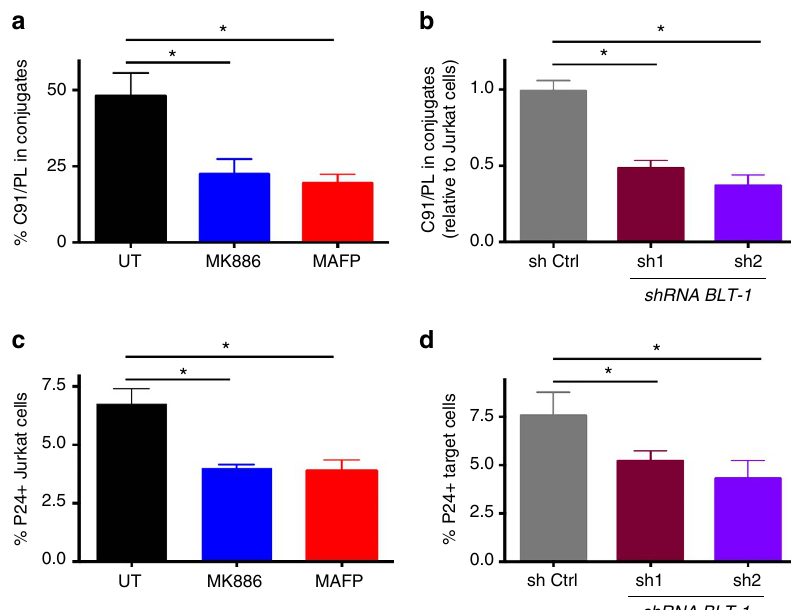
Figure 5 | LTB4 secretion favours HTLV-1 viral transmission in vitro. ( a ) Blocking LTB4 production by C91/PL cells reduces the formation of cellular contacts with Jurkat cells. C91/PL cells were pretreated (or not) with either MK886 or MAFP. C91/PL and Jurkat cells were stained with different cell trackers to distinguish them. C91/PL and Jurkat cells were cocultured (ratio 1:1) for 30min. The number of cell–cell contacts, or conjugates formed was then counted. P value ¼ 0.01; n ¼ 4; mean ± s.e.m.; Friedman test, Dunn’s post hoc test. ( b ) Blt-1 KD Jurkat cells form fewer contacts with C91/PL cells. C91/PL cells were cultured with blt-1 KD Jurkat cells (sh1 or sh2), or Jurkat cells transduced with a control shRNA. The number of conjugates was then determined after 30min. Data were normalized to the number of conjugates formed with Jurkat cells. P value ¼ 0.03; n ¼ 3; mean ± s.e.m.; Friedman test, Dunn’s post hoc test. ( c ) Blocking LTB4 secretion by C91/PL reduces HTLV-1 viral transfer to Jurkat cells. C91/PL were treated or not with MK886 or MAFP, washed, stained with cell tracker and cultured for 1h with Jurkat cells. The percentage of P24-gag-positive Jurkat cells was then determined by flow cytometry. P value ¼ 0.02; n ¼ 4; mean ± s.e.m.; Friedman test, Dunn’s post hoc test. ( d ) Blt-1 downregulation on Jurkat cells reduces HTLV-1 spread. C91/PL cells were stained with cell tracker, and cultured with blt-1 KD Jurkat cells (sh1 or sh2), or Jurkat cells transduced with a control shRNA for 1h. The percentage of P24-gag-positive Jurkat cells was then determined by flow cytometry. P value ¼ 0.04; n ¼ 4; mean ± s.e.m.; Friedman test, Dunn’s post hoc